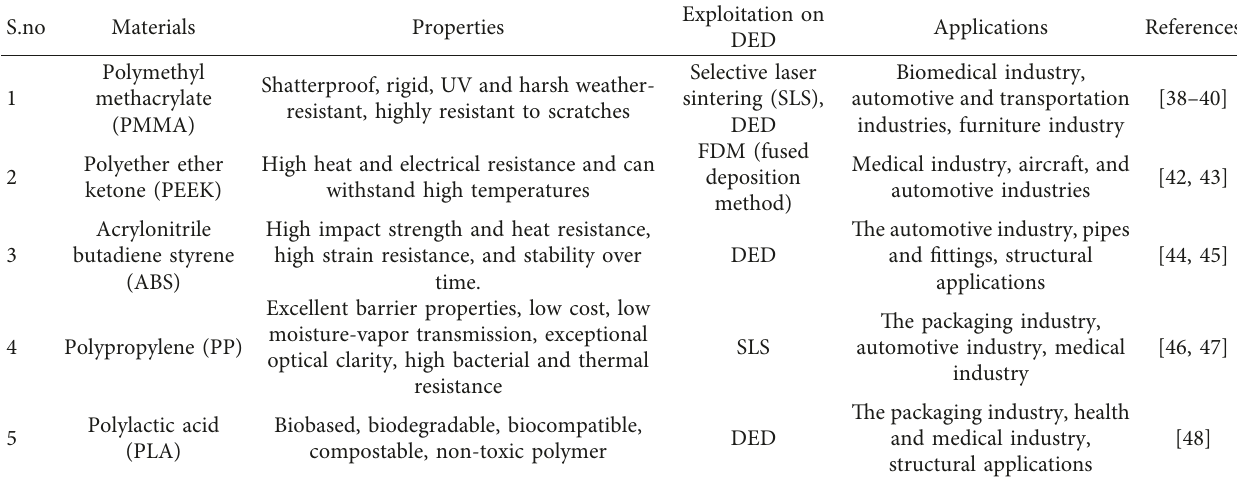
Table 5: Types of feed materials (polymers).